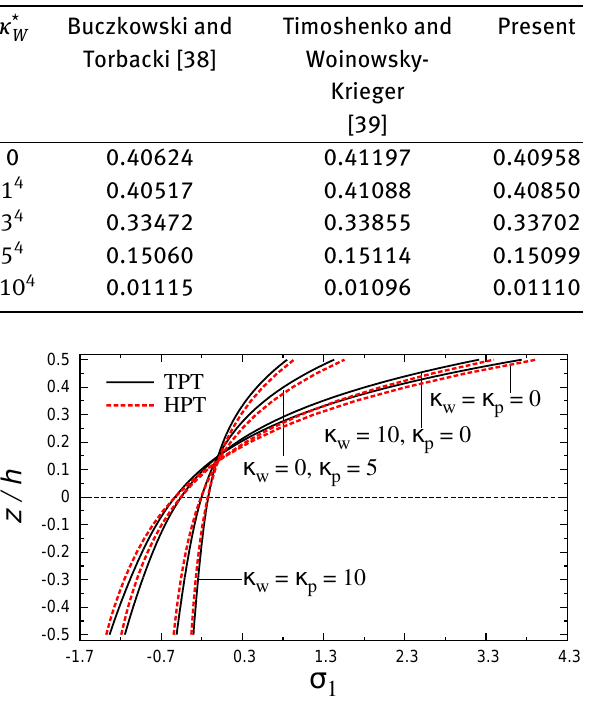
Figure 5: Through-the-thickness distributions of stress σ 1 of the EG thick square plate on elastic foundations ( a = 4 h , k = 1.5) .